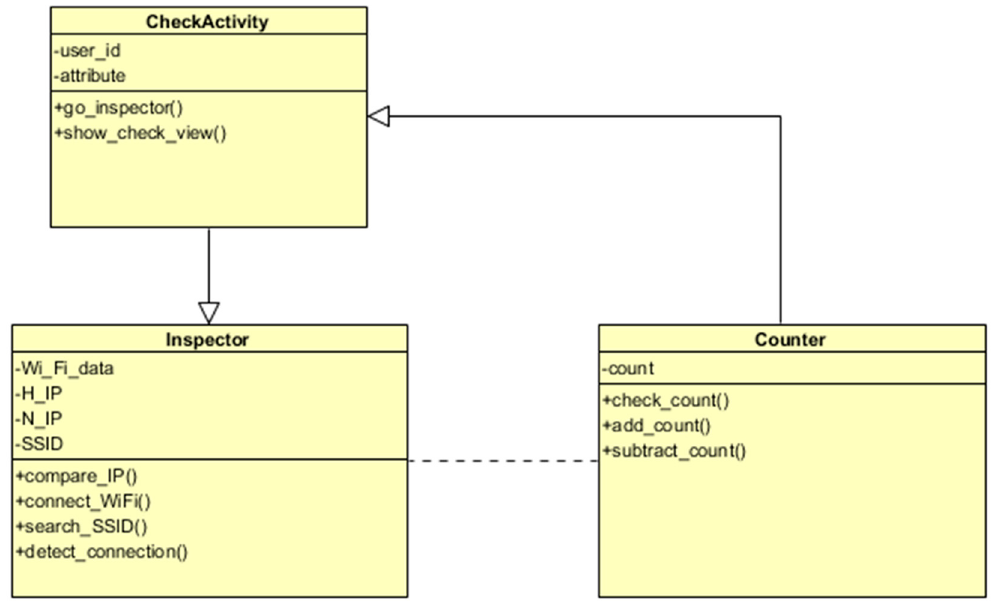
Figure 8. In-Home Headcount Checking Java Android UML.